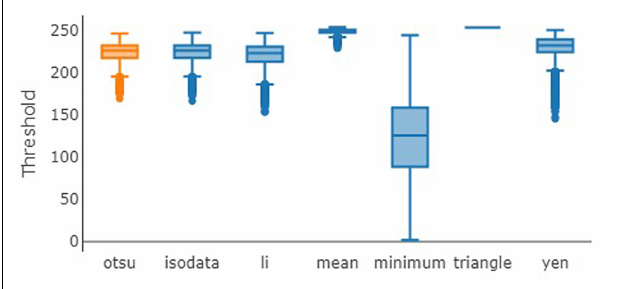
FIGURE 5 | Threshold values calculated for all vignettes using different algorithms. Colors show threshold algorithm type as orange (reference algorithm) and blue (binary). Values are expressed as boxplots, showing median (horizontal line), first and third quartile range (box), minimum and maximum values (error bars), and outliers (dots). Based on all imaged particles ( n =